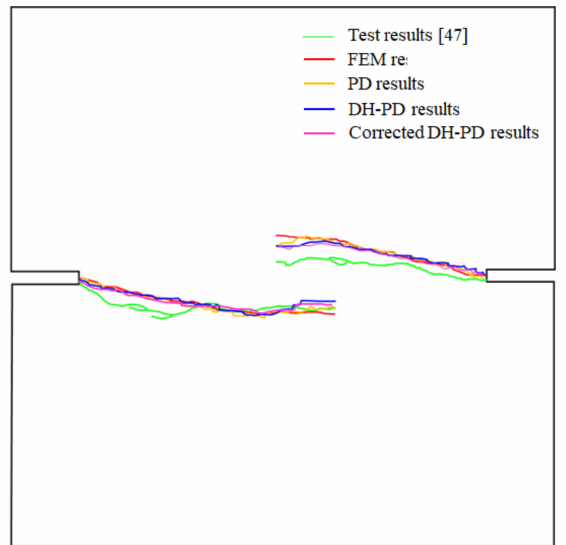
Figure 20. Comparison of the experimental and numerical (from the models of current study and other numerical studies) crack paths